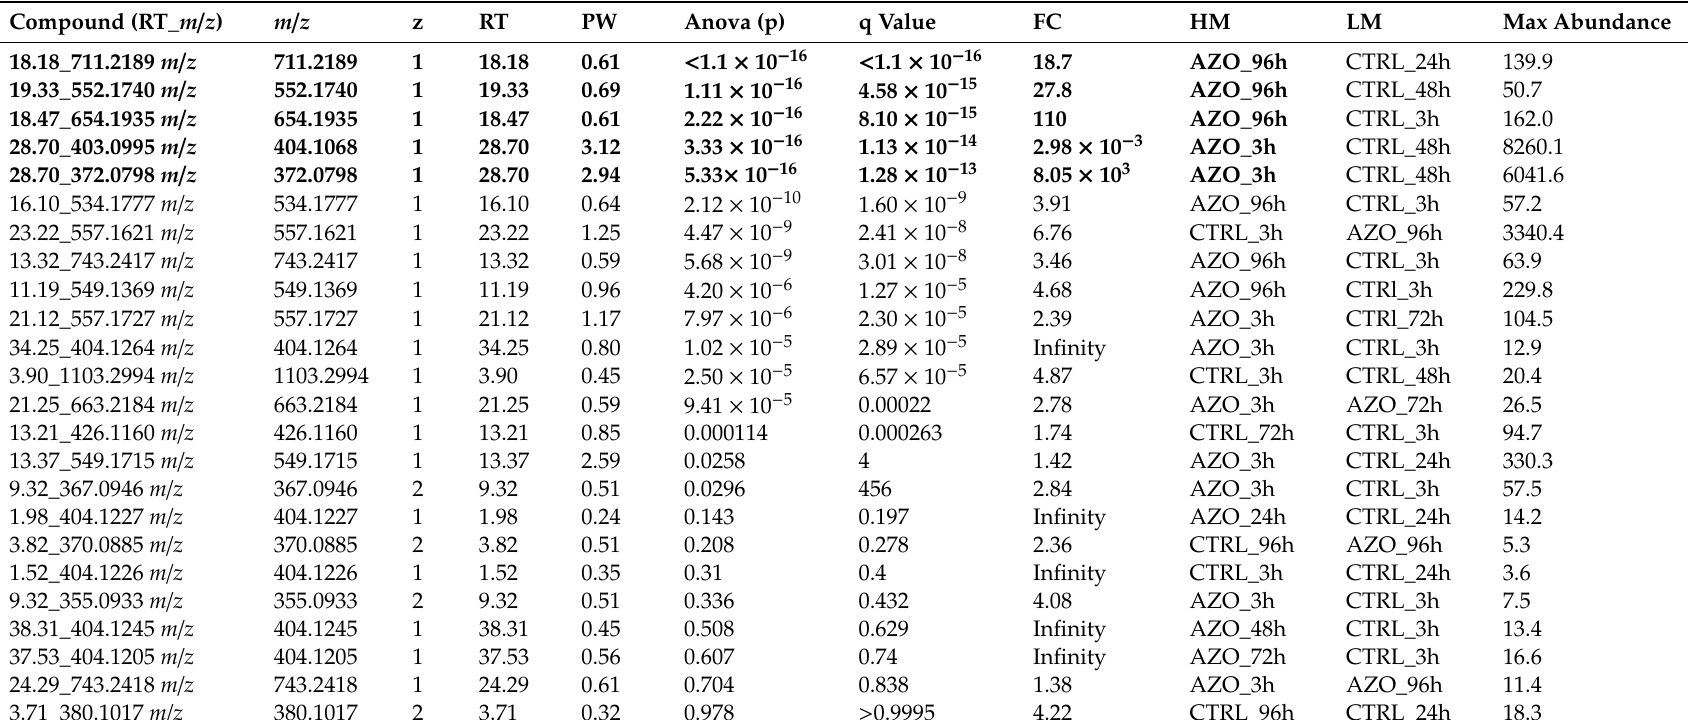
Table 1. Possible azoxystrobin containing peaks di ff erentially present in the treated maize root as compared untreated roots over 96 h. The searched azoxystrobin SDF structures and related metabolites present here were not all validated since most of them were also present in the control roots. Their relative max abundance as compared to the control and spectral counting is shown in the last column, where clearly the relative max abundance was recorded respectively for compounds at m / z 404.1068, 372.0798, 549.1369, 549.1715, 654.1935, 711.2189, 557.1727, and 552.1740. In bold are reported the compounds which have been confirmed being azoxystrobin